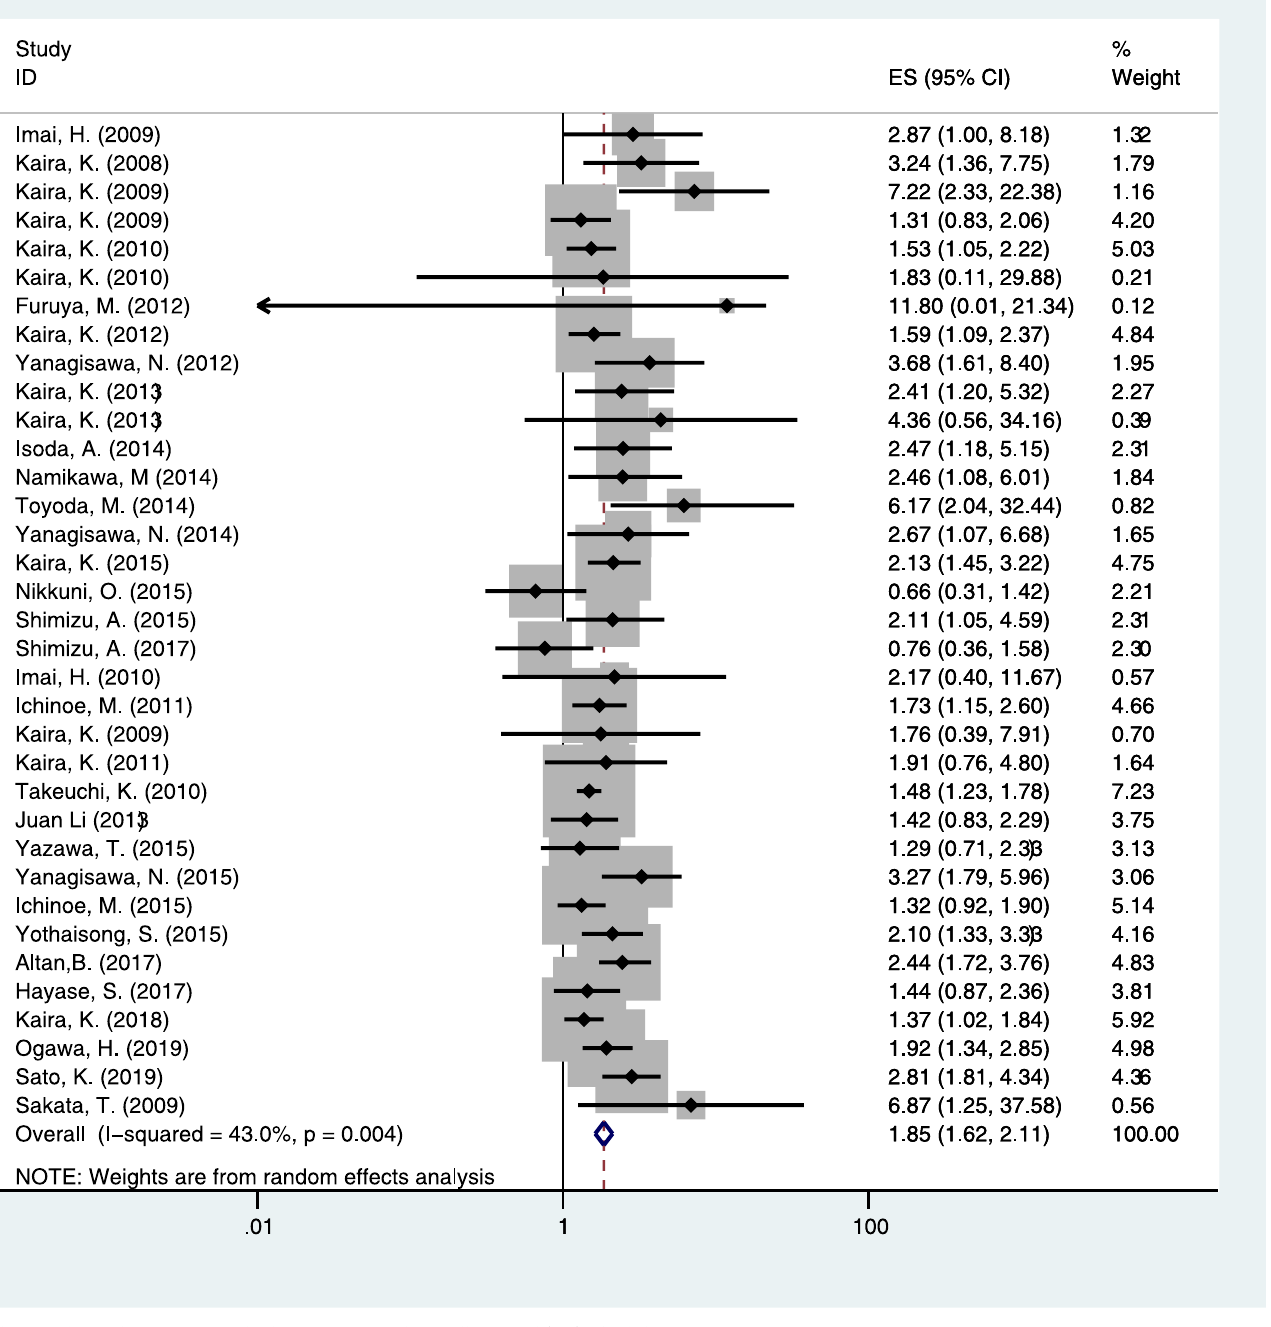
This meta-analysis focused on the relationship between LAT1 status and the prognosis of can- cer patients. In this study, the p value of heterogeneity test for OS was 0.004, and the I 2 value was 43.0%. The random effect model was used. The results showed that there was a significant